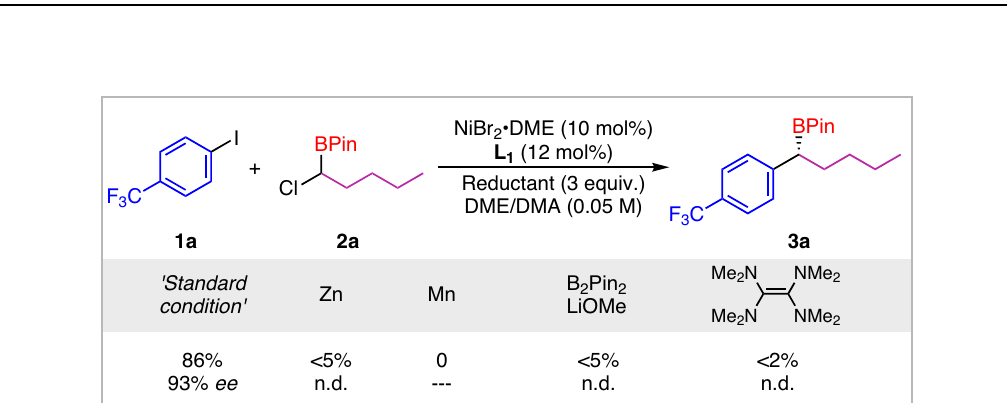
Fig. 2 The reaction with other reductants. Comparison reaction with other reductive